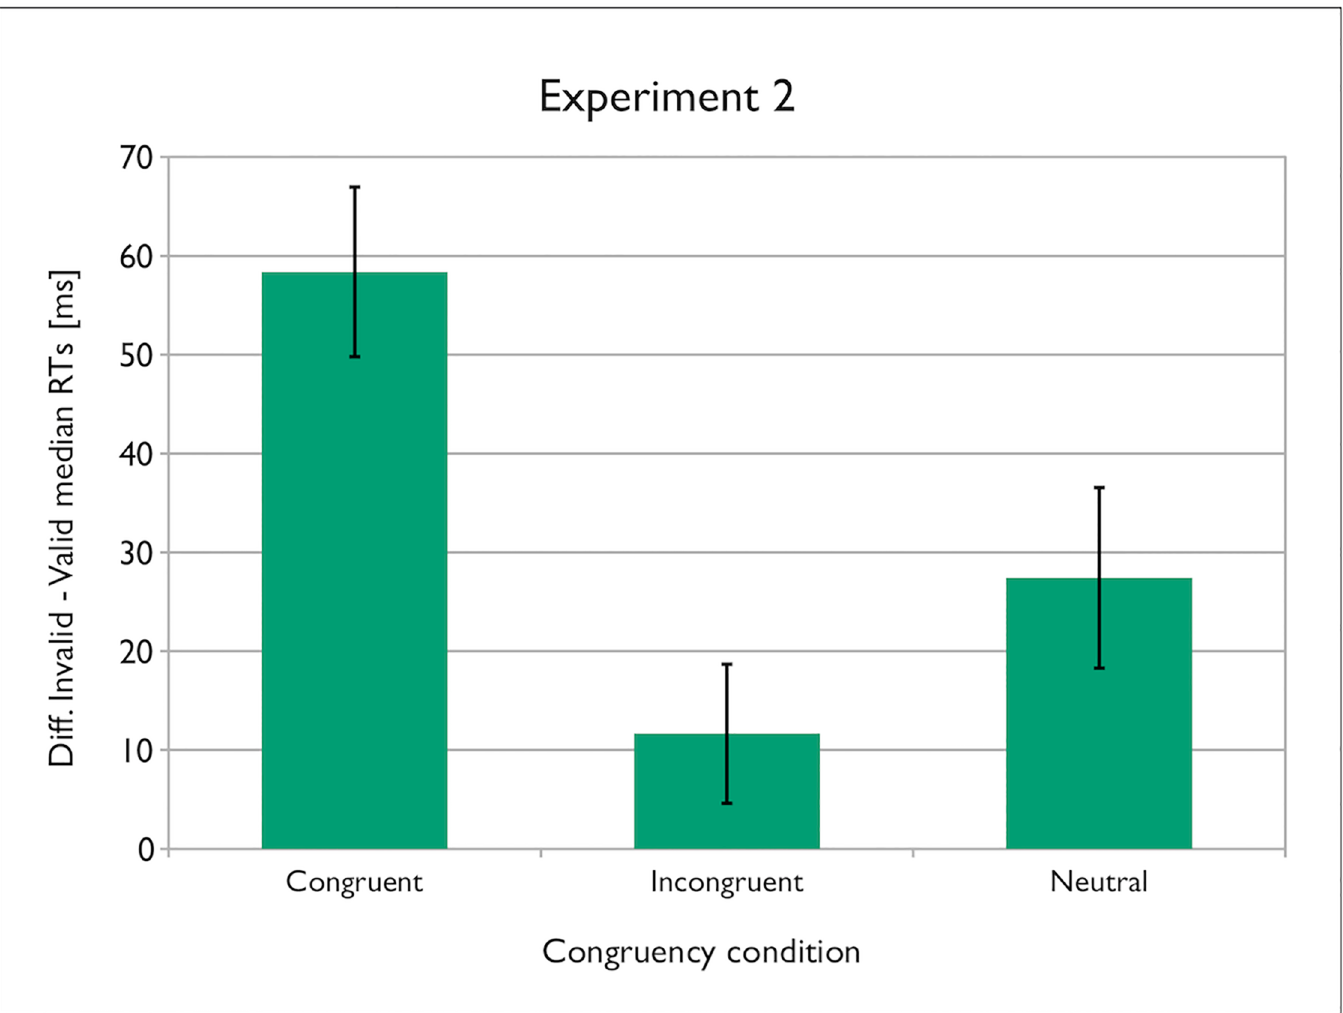
Fig 5. Gaze-cueing effect as a function of gaze congruency in Experiment 2. Error bars represent the confidence intervals (95% CIs) adapted for within- participants designs according to Cousineau ’ s [31] procedure.